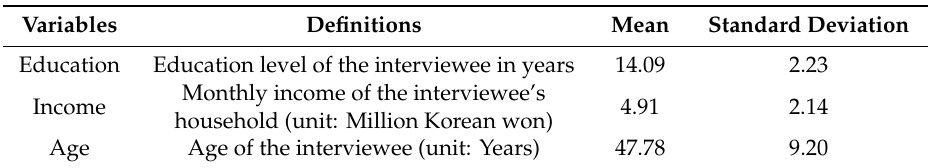
Table 4. Basic information about the covariates